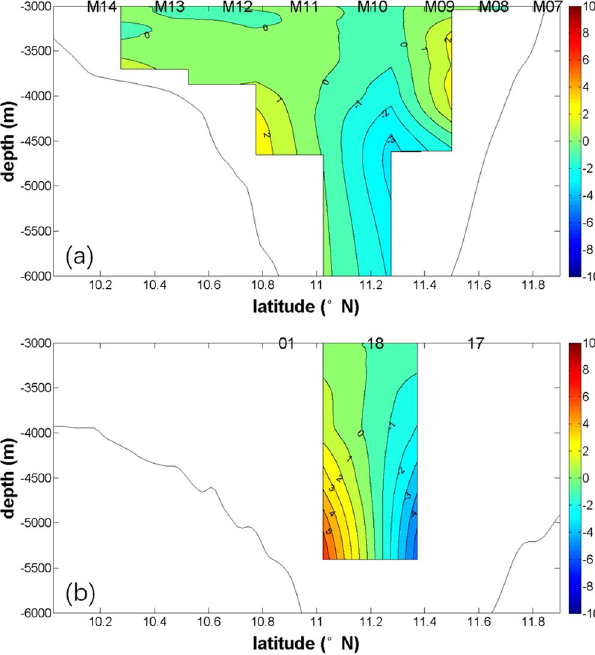
Figure 7. Geostrophic flow. Geostrophic velocity referred to 3000 dbar during 2016S2 ( a ) and 2016S1 ( b ). Contour intervals are 1 cm/s. Figures were generated using